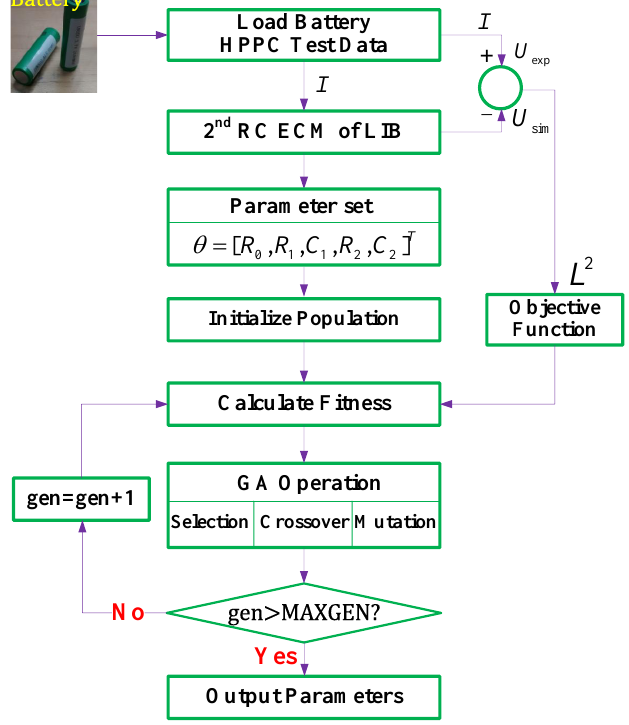
Figure 5. The flowchart of Li-ion battery parameters identification using GA.